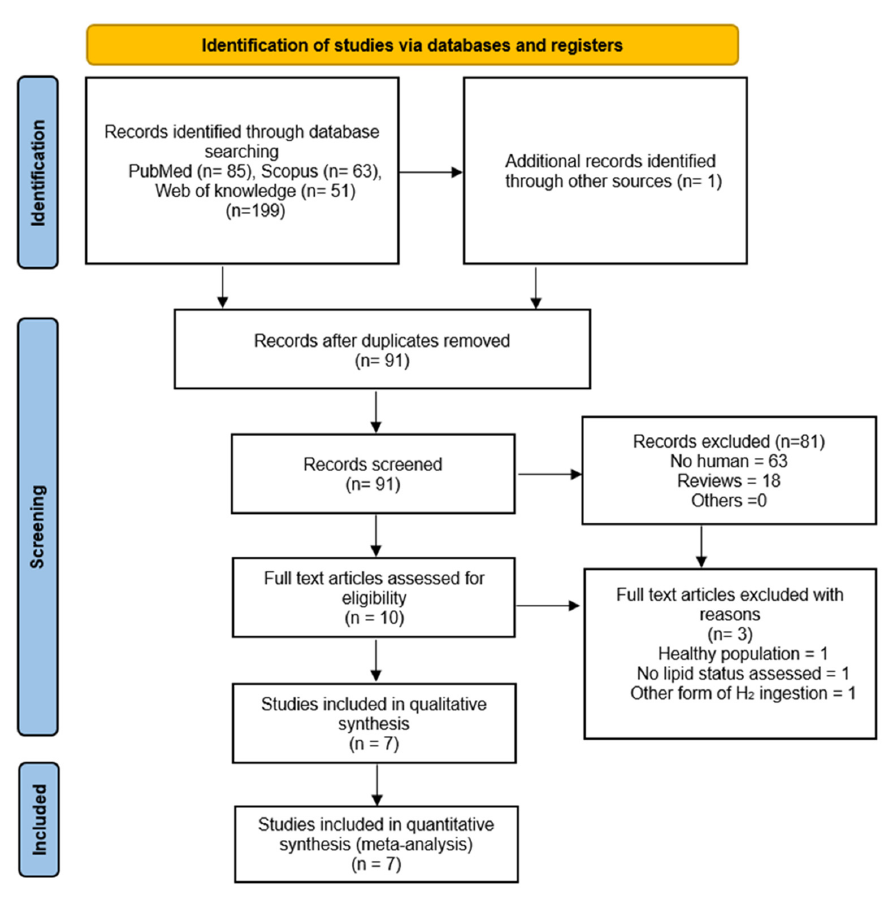
Figure 1. Prisma flow diagram .